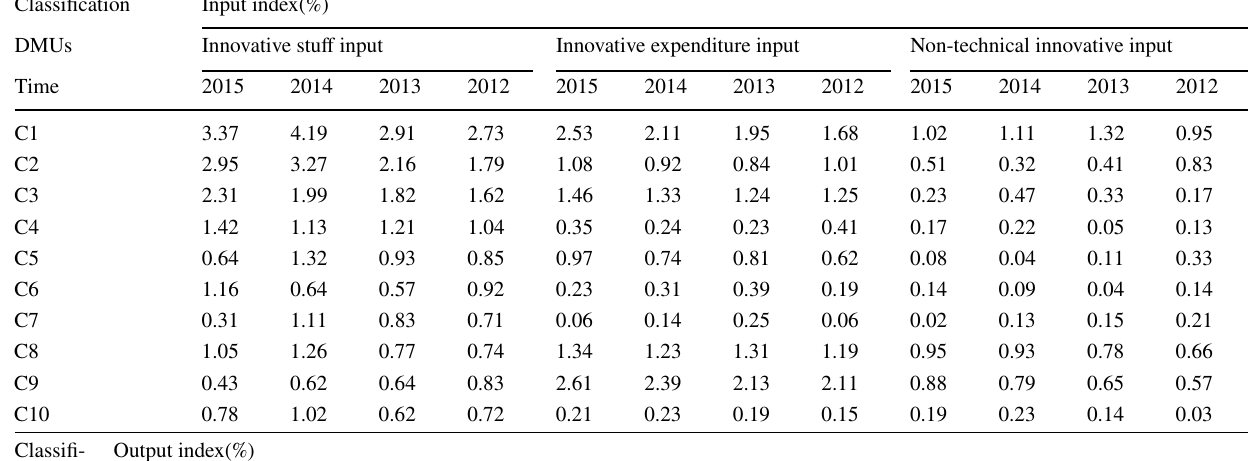
Table 1 10 oil production plants’ data for technical innovation input and output indicators from 2012 to 2015